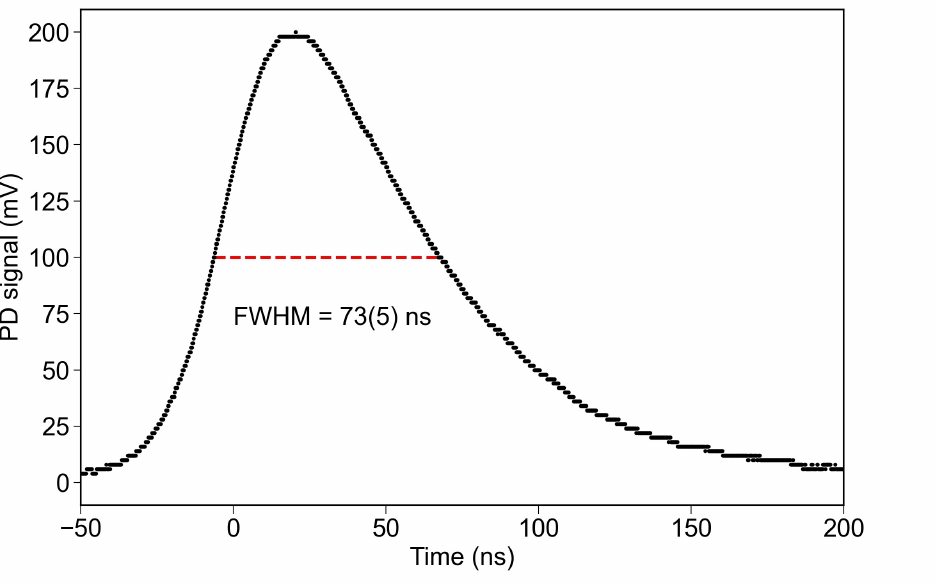
Figure 7. FWHM Pulse duration of the Ti:sapphire